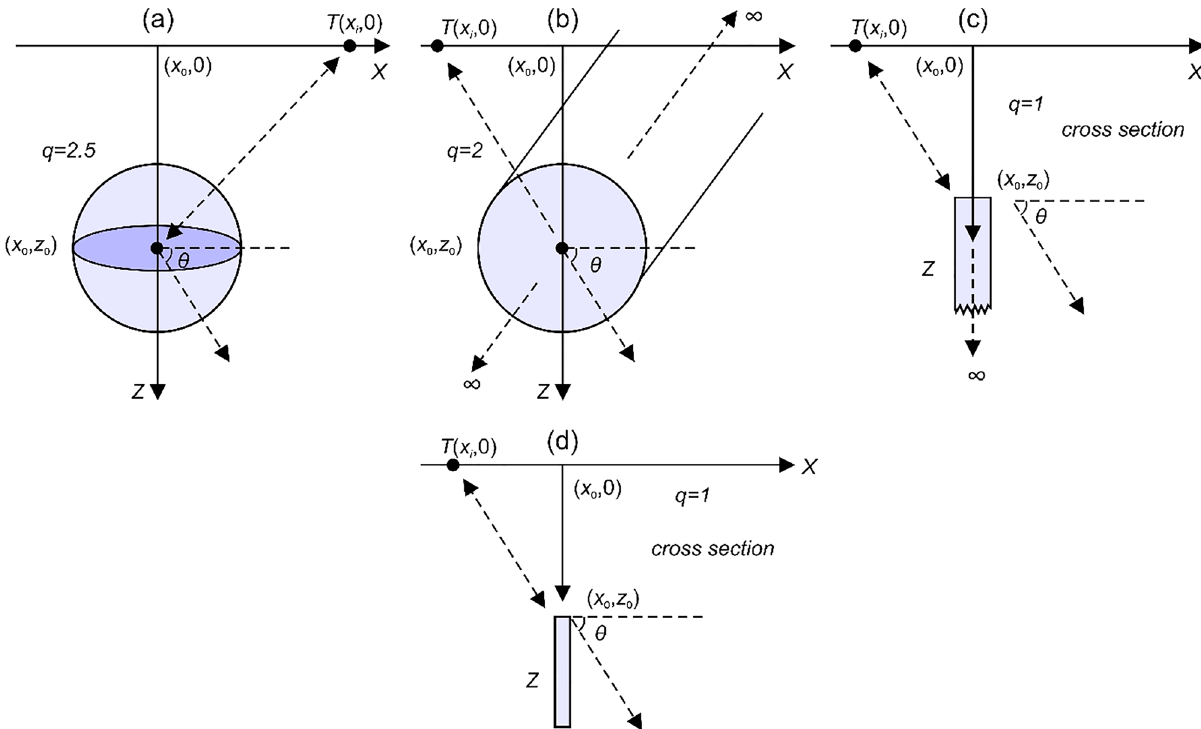
Figure 1. Illustrations of geometries and parameters of ( a ) a sphere, ( b ) an infinitely long horizontal cylinder, ( c ) a thin dyke, and ( d ) a thin